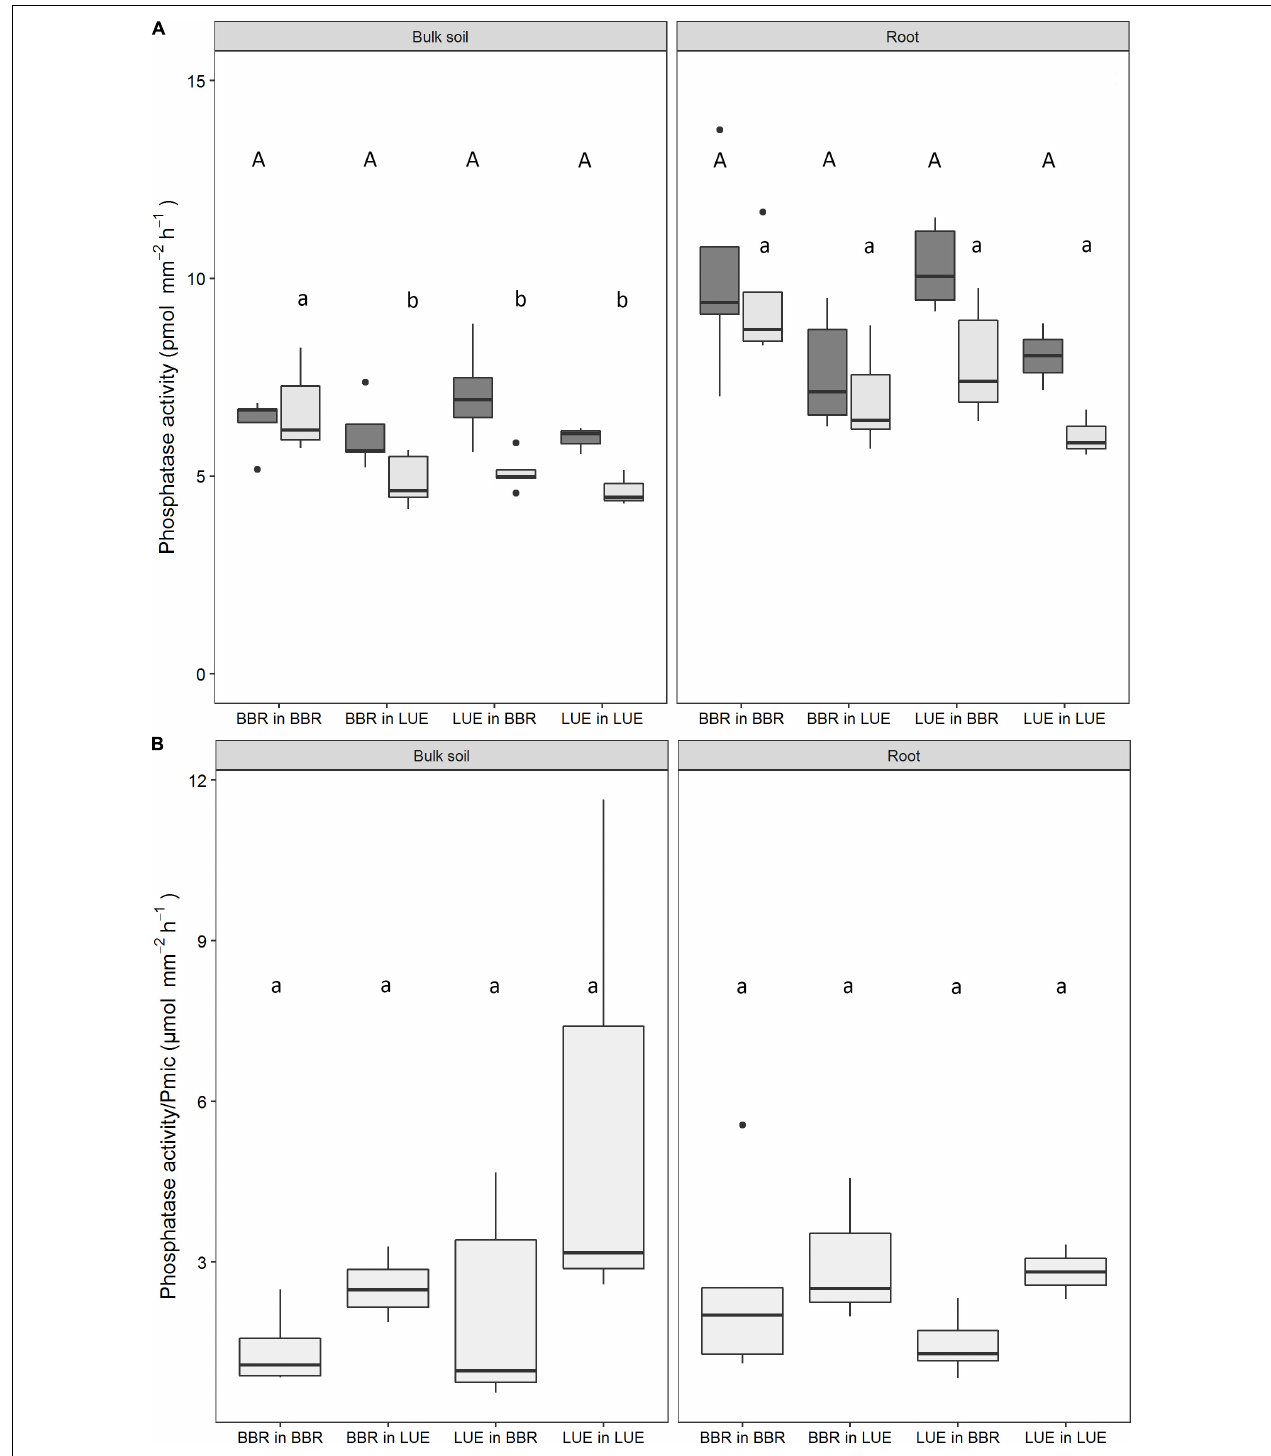
FIGURE 4 | Potential phosphatase activity (PA) measured in the bulk soil and on the surface of the roots using zymography (A) and the ratio between potential PA and microbial P (P mic ) in bulk soil and in the rhizosphere (PA on the root divided by P mic in the rhizosphere) (B) in a rhizobox experiment with beech ( Fagus sylvatica L.) saplings originating from the sites Bad Brückenau (BBR) and Unterlüss (LUE). The saplings were grown in material from the Bv horizon at BBR or from the Bh horizon at LUE. Shown are box plots based on values for replicate rhizoboxes in August of the first (dark gray) and second (light gray) season ( n = 5, except n = 3 for LUE in LUE); different letters indicate significant differences between means according to the Tukey post hoc test (uppercase letters, first growing season; lowercase letters, second growing